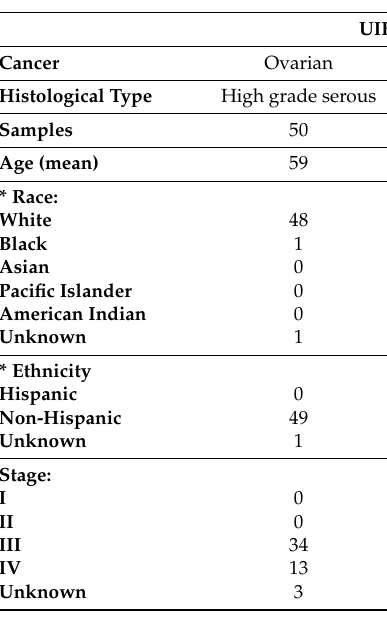
Table 1. Patient clinical characteristics. Data is divided by tumor type and by origin of samples (University of Iowa, UIHC, or TCGA). * Self-reported race and